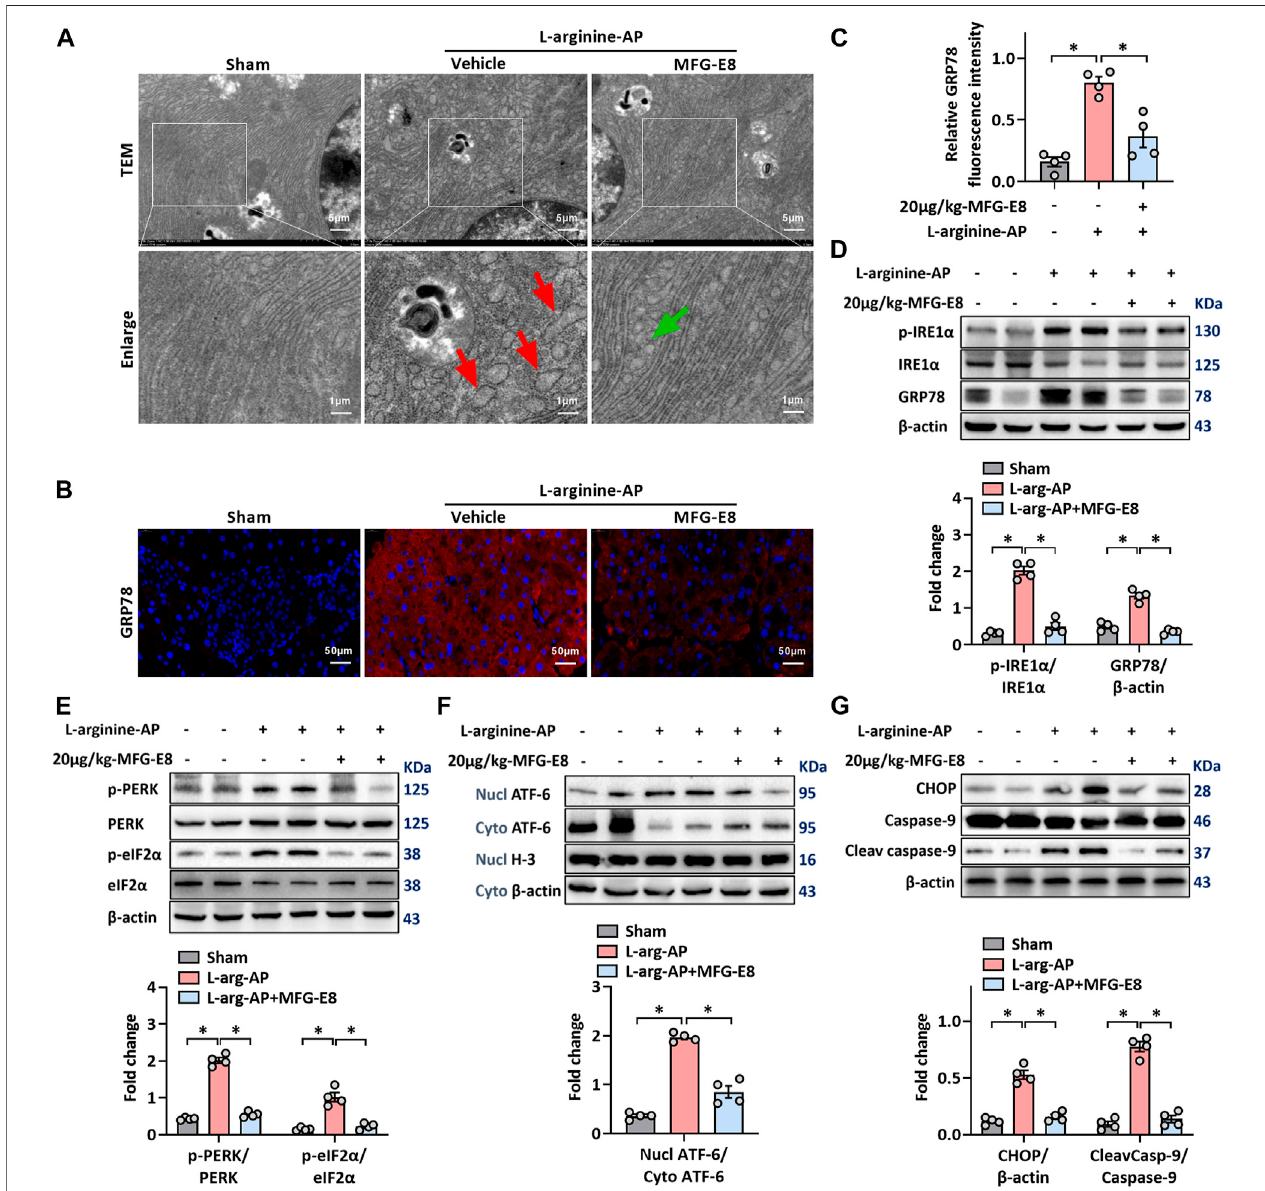
FIGURE 2 | Exogenous MFG-E8 alleviates pancreatic ER stress in vivo . In mice, arginine-AP stress was induced by 2 h intraperitoneal injections of 4.0 g/kg L-arginine. At 2 h after the last injection of L-arginine, normal saline (vehicle) or 20 μ g/kg MFG-E8 were administered through intraperitoneal injection. The animals were sacri fi ced at 69 h after MFG-E8 treatment (i.e., 72 h after the fi rst injection of L-arginine). Blood and tissue samples were collected. (A) Ultrastructural alterations in the pancreas(Transmissionelectron microscopy); (B,C) Representativephotos ofGRP78 stainingand quantitative ofGRP78 staining; (D) Westernblotanalysisofthe expressionofGRP78,phospho-IRE1 α andIRE1 α inthepancreas; (E) Westernblotanalysisoftheexpressionofphospho-PERK,PERK,phospho-eIF2 α andeIF2 α inthe pancreas; (F) Westernblotanalysisoftheexpressionofnucl-ATF-6,cyto-ATF-6,nucl-H3andcyto- β -actininthepancreas; (G) Westernblotanalysisoftheexpressionof CHOP, caspase-9 and cleaved caspase-9 in the pancreas. n (cid:1) 4 – 6/group, error bars indicate the SEM; p p < .05 versus Sham group; # p < .05 versus Vehicle group. MFG-E8, milk fat globule EGF factor 8; AP, acute pancreatitis; GRP78, glucose-regulated protein 78; eIF2 α , eukaryotic initiation factor 2 α ; ATF-6, Activating Transcription Factor 6; CHOP, C/EBP homologous protein; Nucl, nucleus; Cyto, cytoplasm; H-3, histone-3; PERK, PKR-like endoplasmic reticulum kinase.